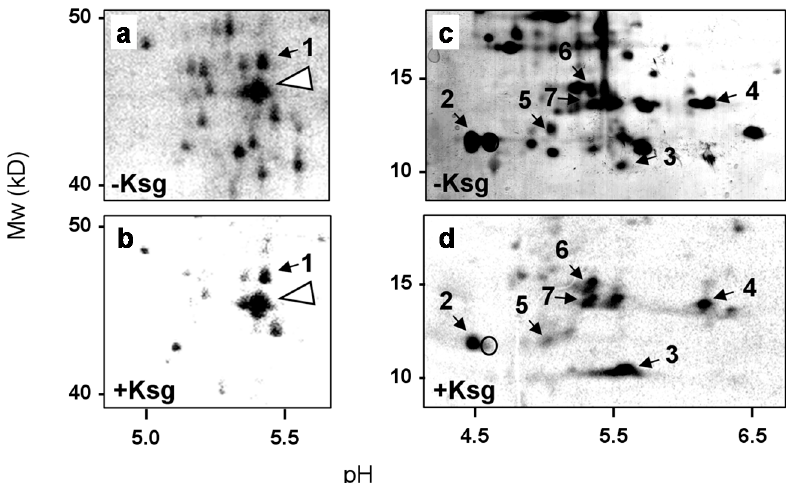
Figure 2. 2D gel analysis performed to identify selectively synthesized proteins in the presence of Ksg. ( a ) and ( c ) Sections of the 2D gel performed with samples withdrawn from the untreated strain; ( b ) and ( d ) the same sections of the 2D gel used for the separation of the proteins labeled in the presence of Ksg. The molecular weight is given to the left and the pH values are indicated at the bottom. The proteins identified are numbered according to Table 1. The position of elongation factor 2 is indicated by an arrow head in ( a ) and ( b ) and the position of the unmodified protein uL12 is circled in ( d ). Table 1. Selectively synthesized proteins in the presence of Ksg.